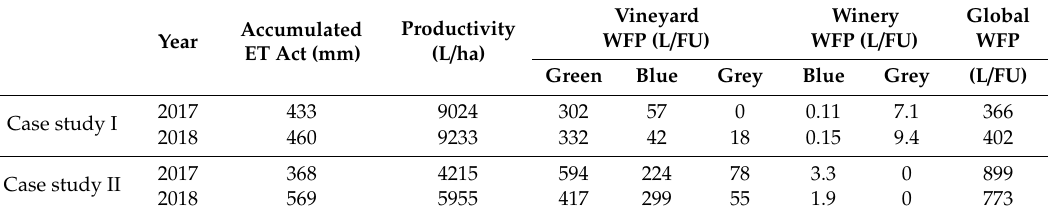
Table 4. Direct water footprint components for case study I and case study II, in 2017 and